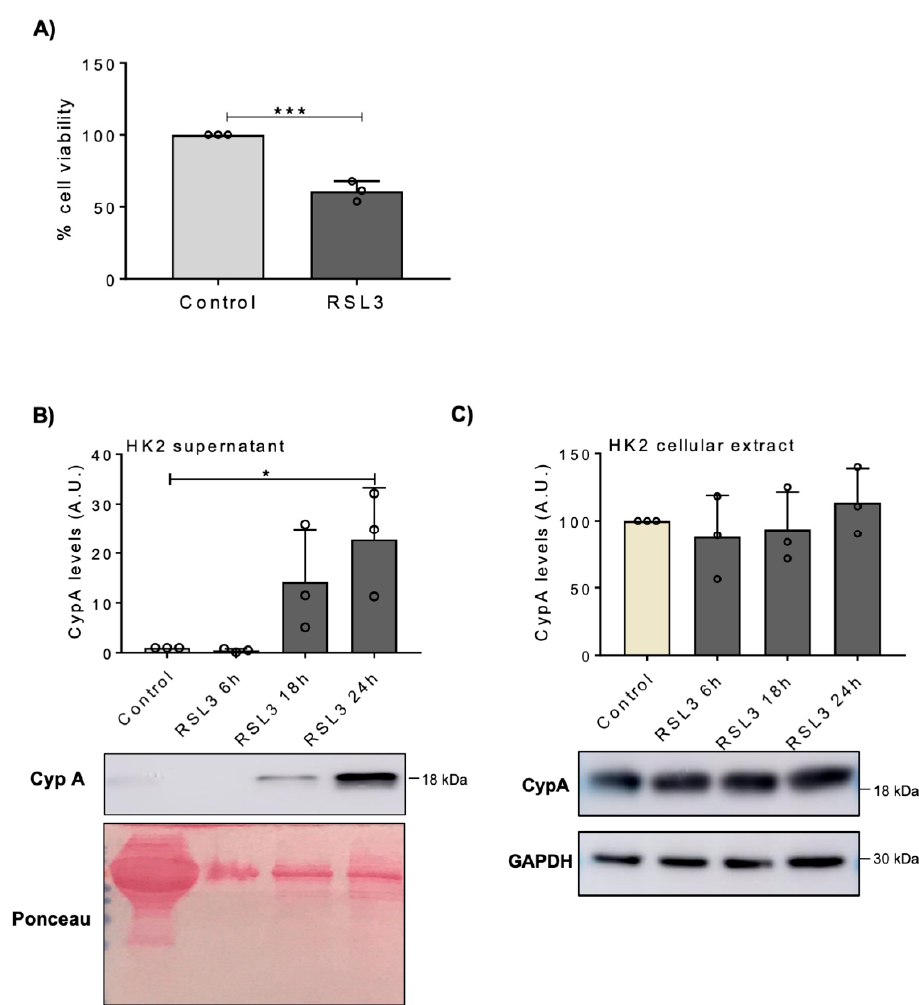
Figure 3. Ferroptosis leads to CypA release in human proximal tubular HK2 cells. ( A ) HK2 cells were exposed to 400 nM RSL3, a ferroptosis inducer, for 24 h and cell viability was assessed by the MTT assay. Mean ± SD of three independent experiments. *** p < 0.001. ( B , C ) HK2 cells were exposed to 400 nM RSL3 for indicated periods of times and CypA was measured by Western blot in cellular supernatants ( B ) and in cellular extracts ( C ) . Quantification and representative image. Mean ± SD of three independent experiments. * p < 0.05. Uncropped gel scans shown in Figure S2A. Overall, these results suggest that CypA is released by kidney tubular cells exposed to lethal stimuli and CypA release is independent of the mechanism of cell death.